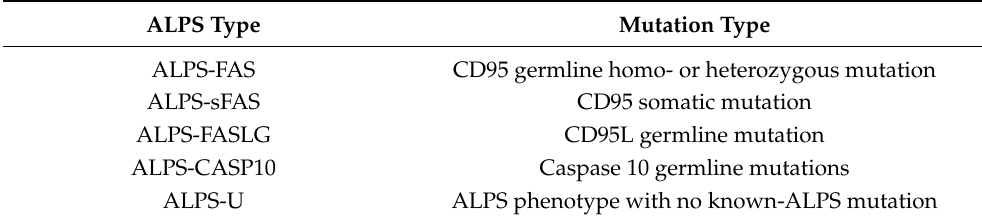
Table 1. Auto-immune lymphoproliferative syndrome (ALPS)